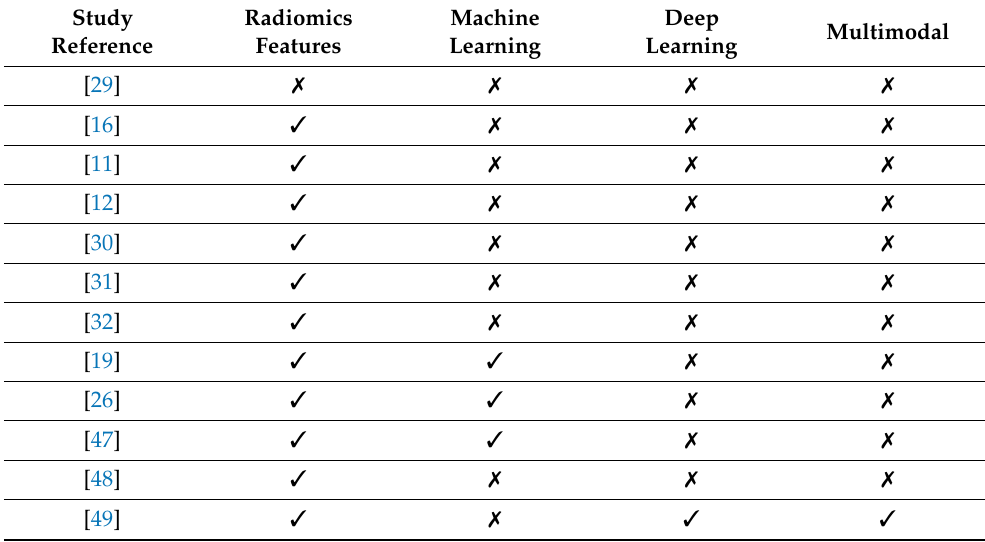
Table 4. Comparison among studies based on using deep learning and multimodal for predicting therapeutic response in